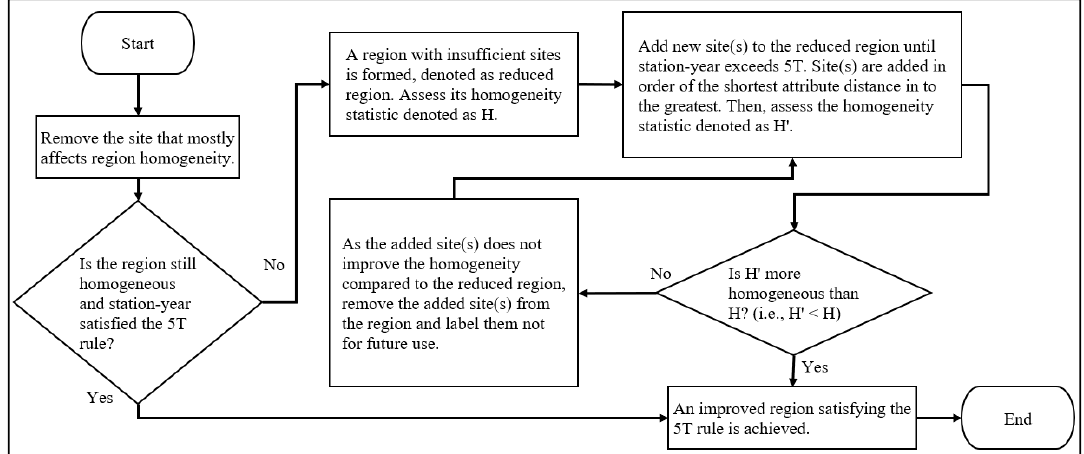
Figure 4. Schematic of the automatic region revision algorithm (ARRA) process.